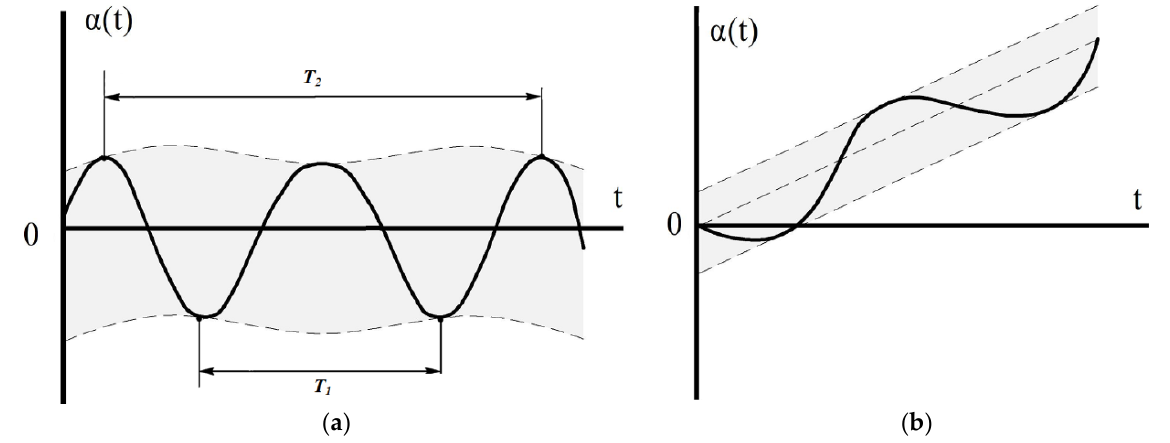
Figure 5. Platform drifts under the action of a shock wave: ( a ) periodic components; and ( b ) systematic and periodic components.